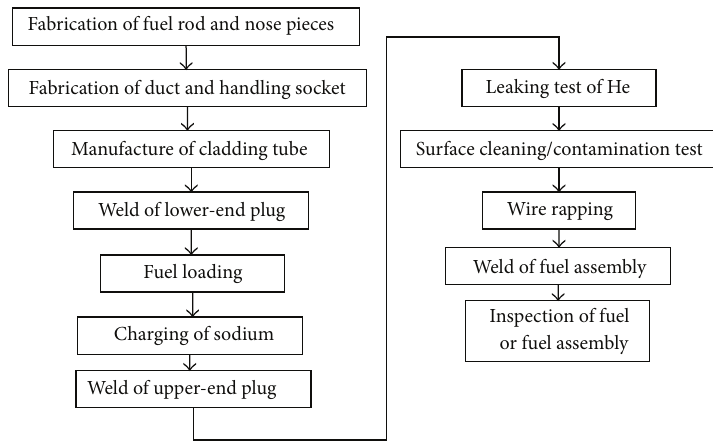
Figure 5: The manufacturing process of SFR nuclear